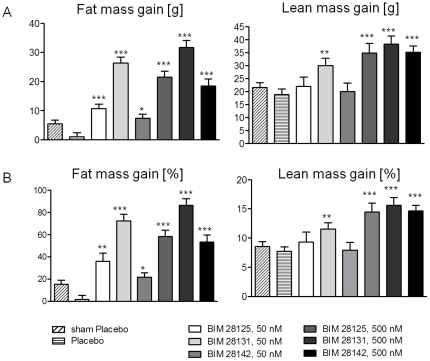
Effect of ghrelin compounds on body composition assessed by NMR scanning.A) absolute gain of fat mass and lean body mass. B) relative gain of fat and lean body mass compared to start of treatment. *: p<0.05, **: p<0.01, ***: p<0.001 compared to placebo.